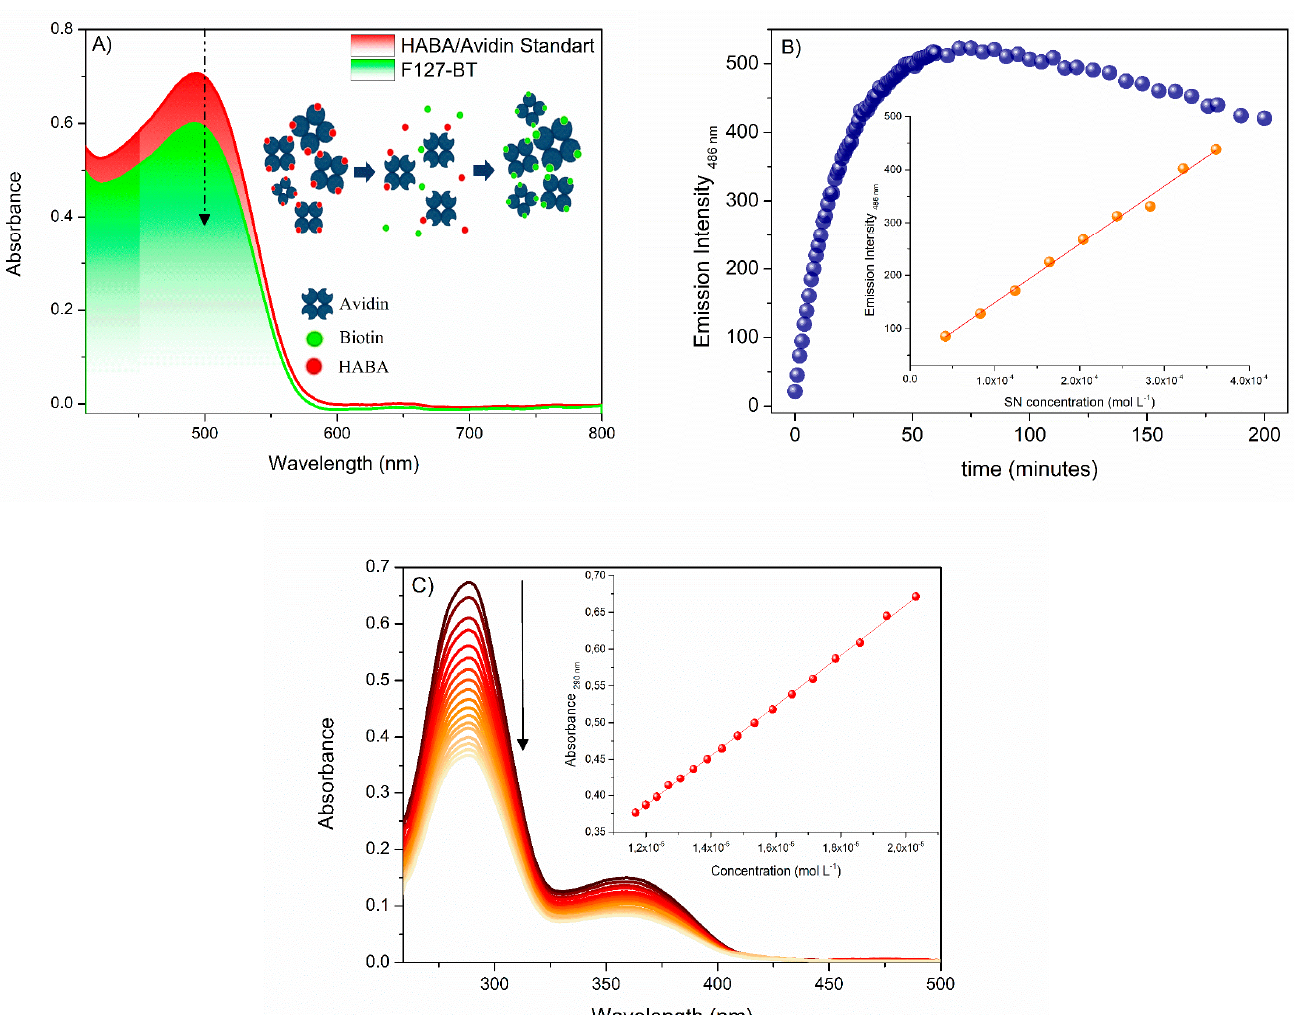
Figure 2. ( A ) HABA/Avidin assay for the determination of BT bound to the F127. Schematic insert of HABA/Avidin behavior in the presence of biotin. ( B ) Kinetic profile of fluorescamine with spermine addition. Insert calibration curve obtained to determine the percentage of SN bound to the F127. ( C ) UV-Vis electronic absorption spectra and curve obtained for the determination of the percentage of AF bound to F127 (30.0 °C, λ max = 290 nm). The black arrow on the side indicates the direction of the fluorescence signal with the titrations.